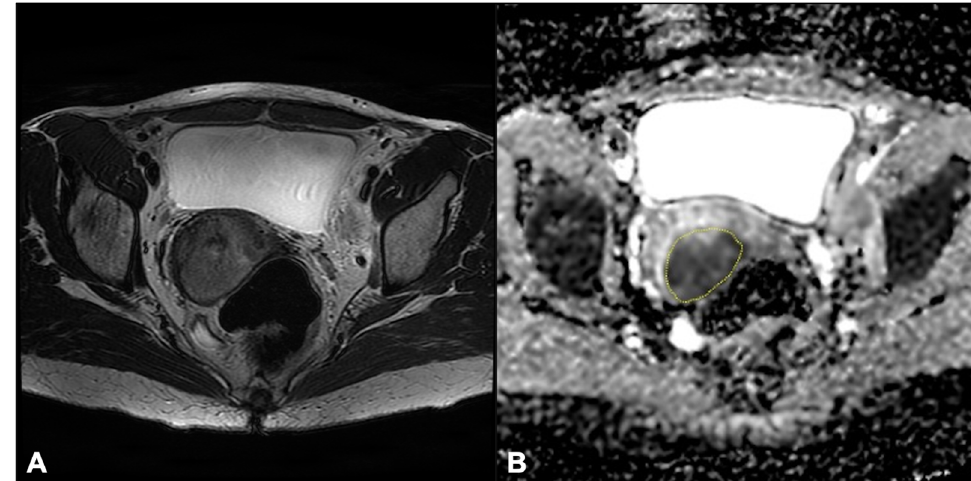
Figure 2. Axial T2-WI shows circumferential tumor tissue occupying the uterine cervix ( A ); 2D-ROI (dashed yellow line) drawn at the corresponding site of the lesion on the axial ADC map ( B ).